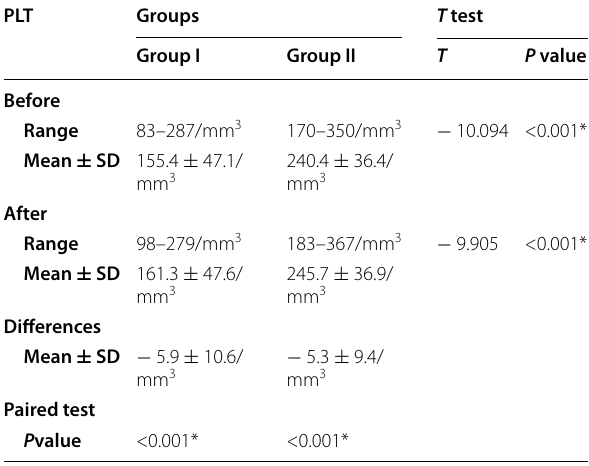
Table 1 Comparison between each group before and after treatment and the two studied groups according to